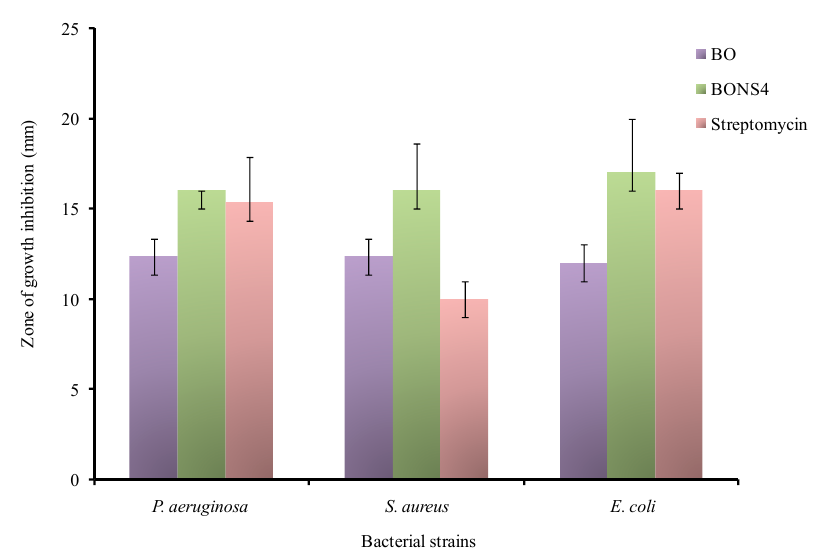
Figure 10. Antibacterial activities of Psoralea corylifolia seed oil. BO-Babchi oil and BONS4-Optimized babchi oil loaded nanosponges.